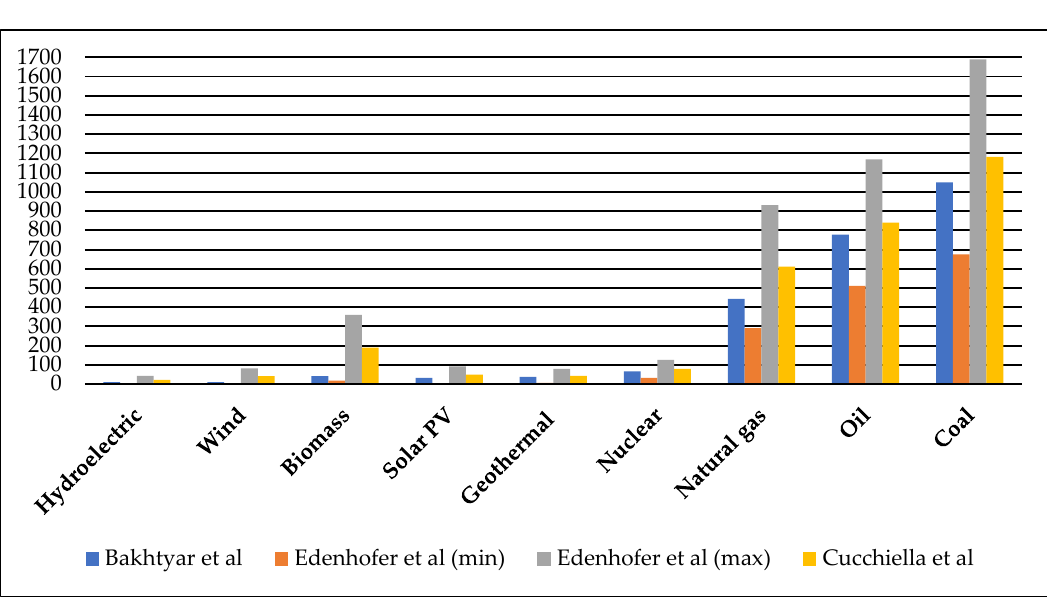
Figure 3. Emissions of carbon dioxide of energy sources. Data expressed in gCO 2 eq/kWh (Cucchiella et al. 2017a; Bakhtyar et al. 2017; Edenhofer et al. 2012).